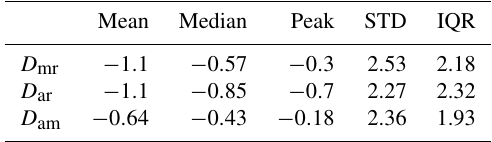
Table 3. Statistical results of the distribution of D mr , D ar and D am (unit: